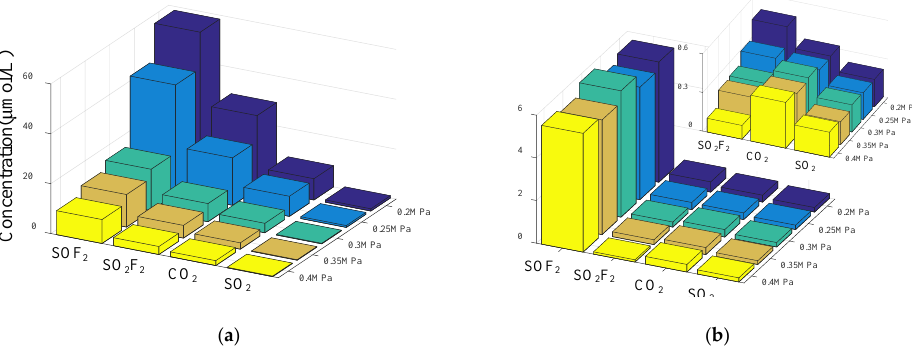
Figure 3. Concentration of SF 6 decomposed components at 96 h: ( a ) Protrusion and ( b ) particles.